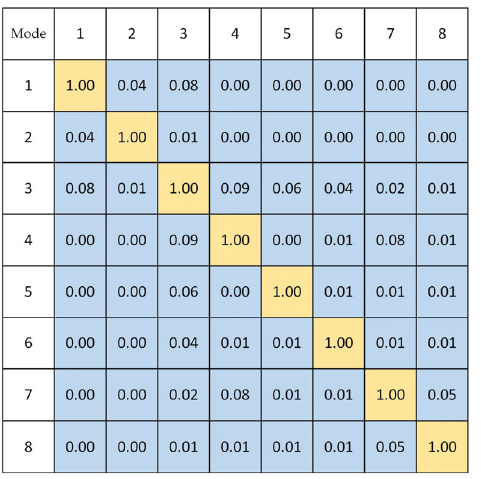
Figure 5. MAC diagram of identification results of the modal test.